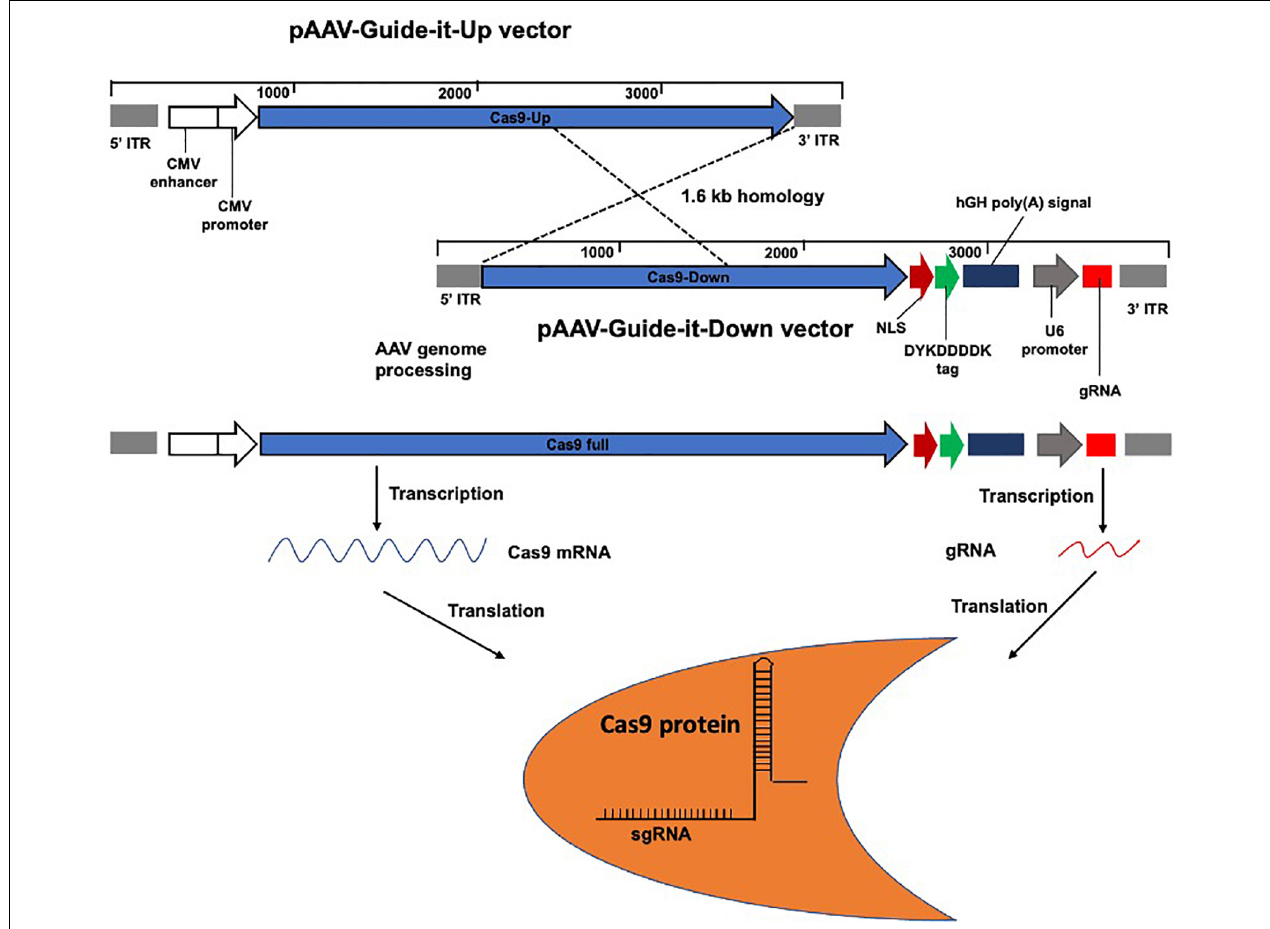
FIGURE 3 | Schematic representation of the larger transgene Streptococcus pyogenes Cas9 (SpCas9) incorporation by splitting into AAV vectors. Two vectors pAAV-Guide-it-Up and Guide-it-Down were used to express full-length SpCas9 and gRNA. gRNA sequence is located downstream of the U6 promoter of the Guide-it-Down vector for binding to the target DNA